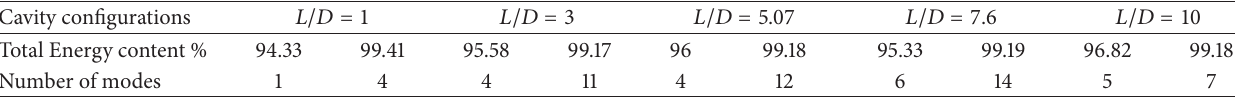
Table 5: The necessary number of POD modes for all cases.